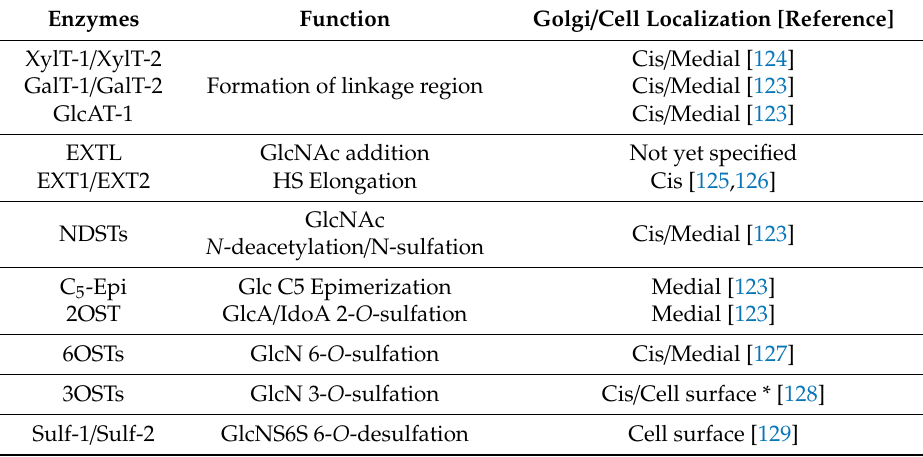
Table 1. Functions and localizations of HS biosynthetic and extracellular modifying